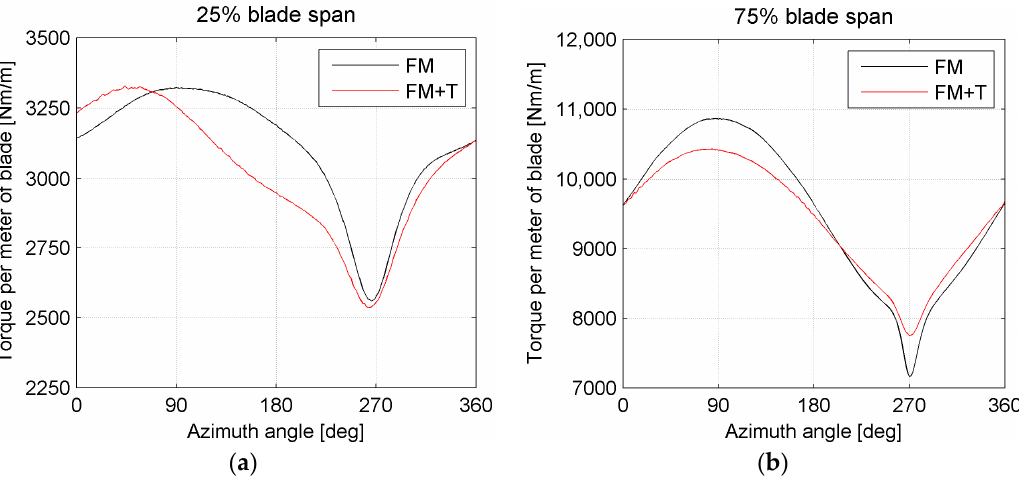
Figure 10. Torque (per meter of blade) contribution at two different spanwise locations: ( a ) 25% and ( b ) 75% of the total span. Comparison between FM and FM + T configurations.